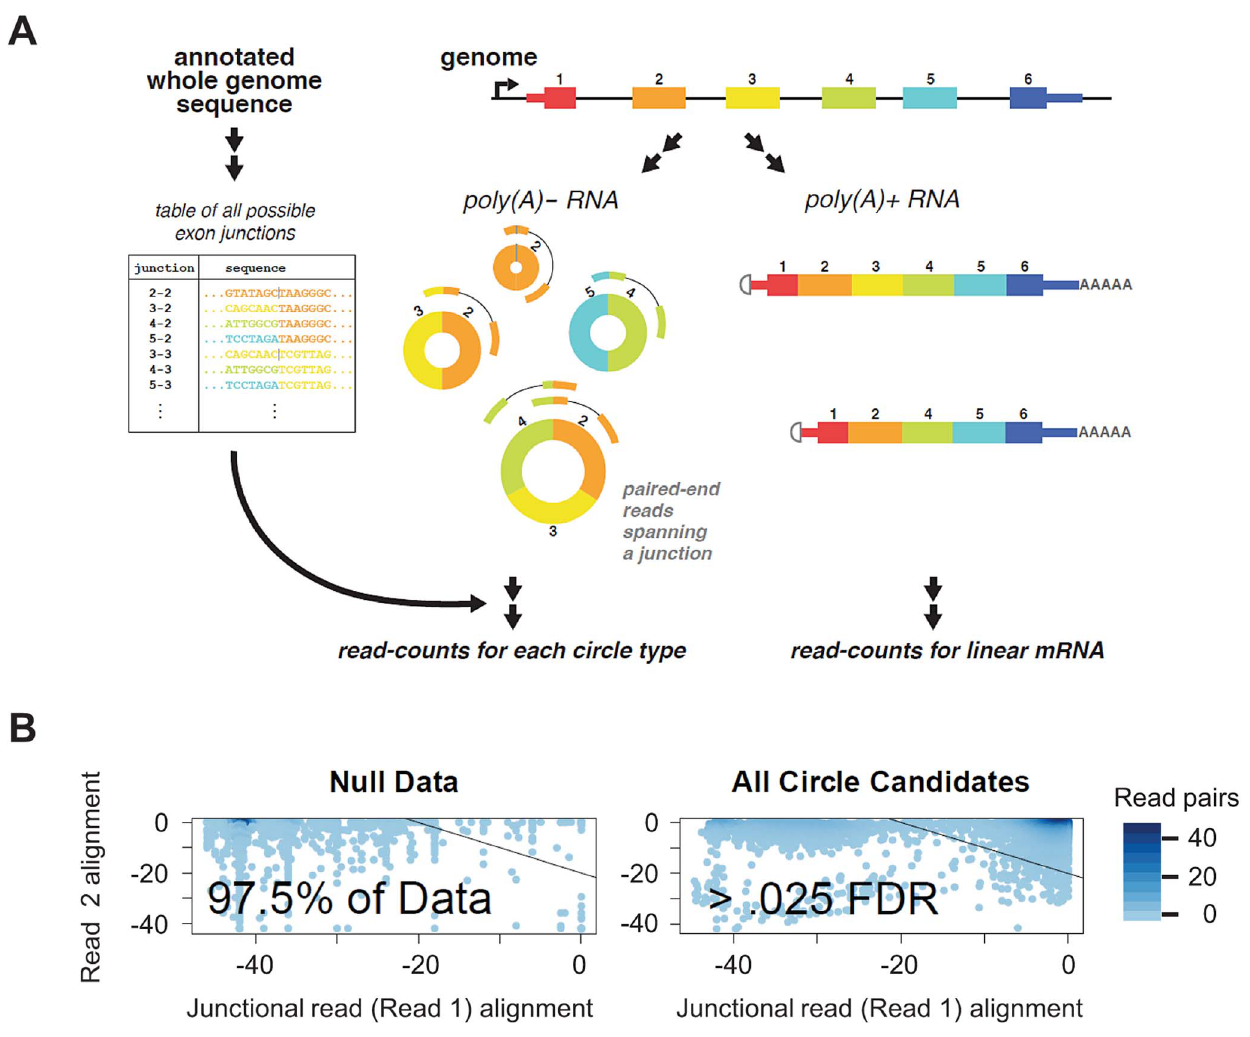
Figure 1. Bioinformatic and statistical method for detecting circular isoforms. A) We created a custom database of all UCSC known-gene annotated scrambled exon-exon junctions. By mapping paired end 76 nt sequencing reads from poly(A) depleted RNA, we detected thousands of distinct circular RNA isoforms, including many cases where multiple circular isoforms are transcribed from the same locus. Our informatic pipeline required that one read (read 1) map to a diagnostic exon x - exon y junction (y , =x) and the other read map within the inferred circular isoform. B) Statistical scores improve filtering: We modeled the distribution of alignment statistics for reads from under an empirical null. Estimating the empirical null distribution of alignment quality for read 1 (required to map to a diagnostic circular exon-exon junction) and read 2 (which need not be junctional) allows us to compute a per-circular isoform FDR and statistically identify artifacts. The bulk of detected circles (illustrated at right) have alignment profiles that distinguish them from those detected under the null model. We used an estimated FDR threshold of .025, shown on